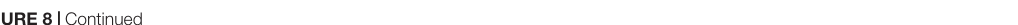
FIGURE 8 | Continued 2/3 pyramidal neurons in the MO of Lrrc4c − / − mice (2–4 months). n = 20 (4) (WT), n = 14 (3) (KO), ns, not significant, Student’s t -test [ (G) sEPSC amplitude: t ( 32 ) = 0.3825, p = 0.7046; sEPSC frequency: t ( 31 ) = 0.6255, p = 0.5362; ( H ) sIPSC amplitude: t ( 30 ) = 1.917, p = 0.0648; sIPSC frequency: t ( 30 ) = 1.382, p = 0.1772]. (I–L) Decreased intrinsic neuronal activity in layer 2/3 pyramidal neurons in the MO of Lrrc4c − / − mice (2–4 months), as shown by decreased current-firing curve, although resting membrane potential and input resistance are normal. n = 20 (4) (WT), n = 21 (4) (KO), ∗ p < 0.05, ns, not significant, Student’s t -test, two-way repeated measures ANOVA with Holm-Sidak multiple comparison test [ (I) t ( 44 ) = 0.8966, p = 0.3748; (J) t ( 44 ) = 1.066, p = 0.2924; (K) interaction, F ( 17 , 663 ) = 1.553, p = 0.0713; genotype, F ( 1 , 39 ) = 0.0918, p = 0.7636; current, F ( 17 , 663 ) = 926.1, p < 0.0001; (L) interaction, F ( 14 , 518 ) = 3.254, p < 0.0001; genotype, F